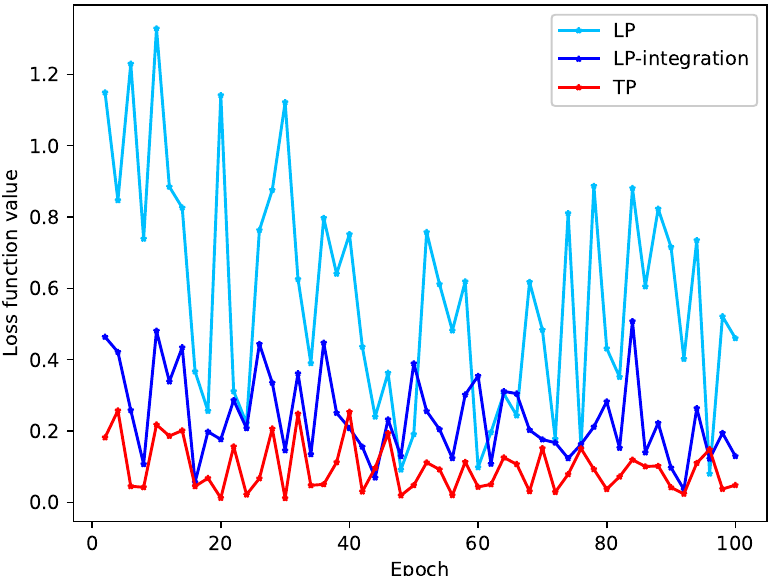
Figure 6. The convergence (oscillation) of the loss function values of LP,integration-LP, and TP